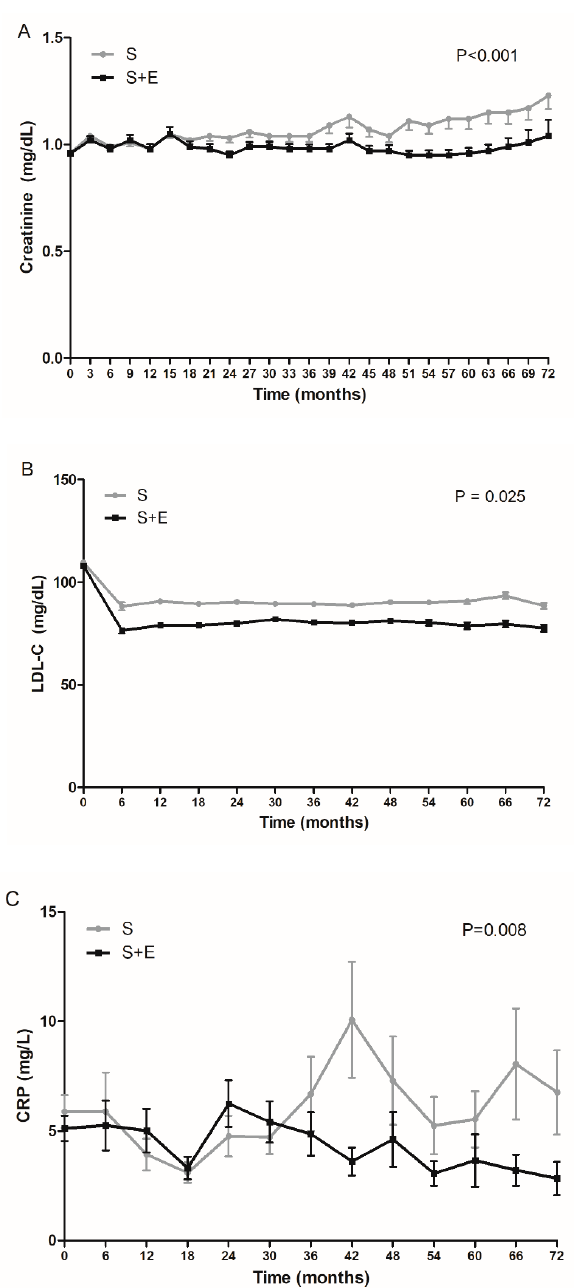
Figure 1. Mean levels of serum creatinine, LDL-cholesterol, and CRP during follow-up by treatment group. ( A ) Serum creatinine, ( B ) LDL-cholesterol, and ( C ) CRP. P -value is for time × group interaction by linear mixed model. Error bars represent the standard error of the mean (SEM). S, simvastatin; S + E, simvastatin + ezetimibe.